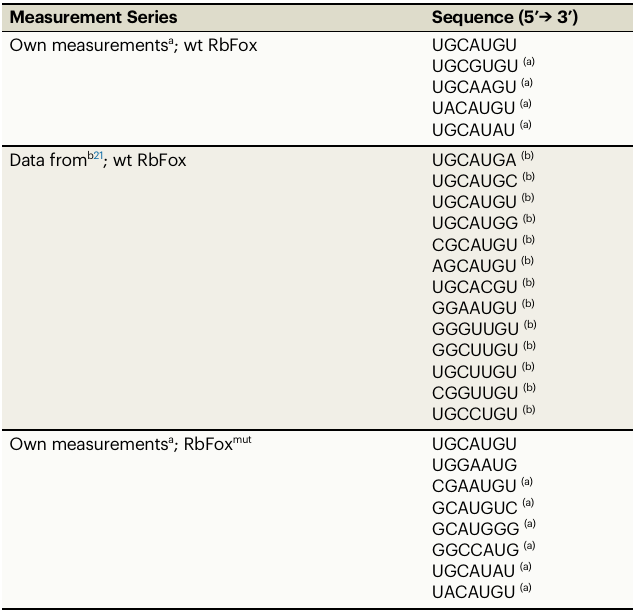
Table 2 | Substrates for af fi nity measurements with individual RNAs Measurement